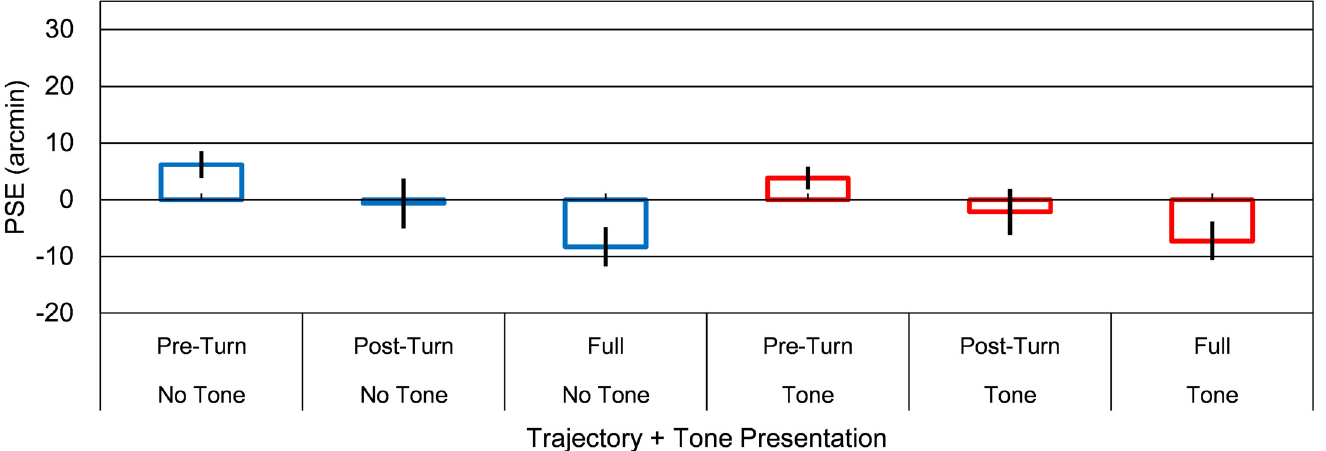
Fig 5. Results of Experiment 3. Group mean PSEs for tone conditions in combination with the 3 trajectory conditions. Positive (negative) PSEs indicate that the vanishing point, starting point, or turn-point was localized forward (backward) within the pre-turn trajectory, respectively. Error bars denote standard errors of the mean ( n =